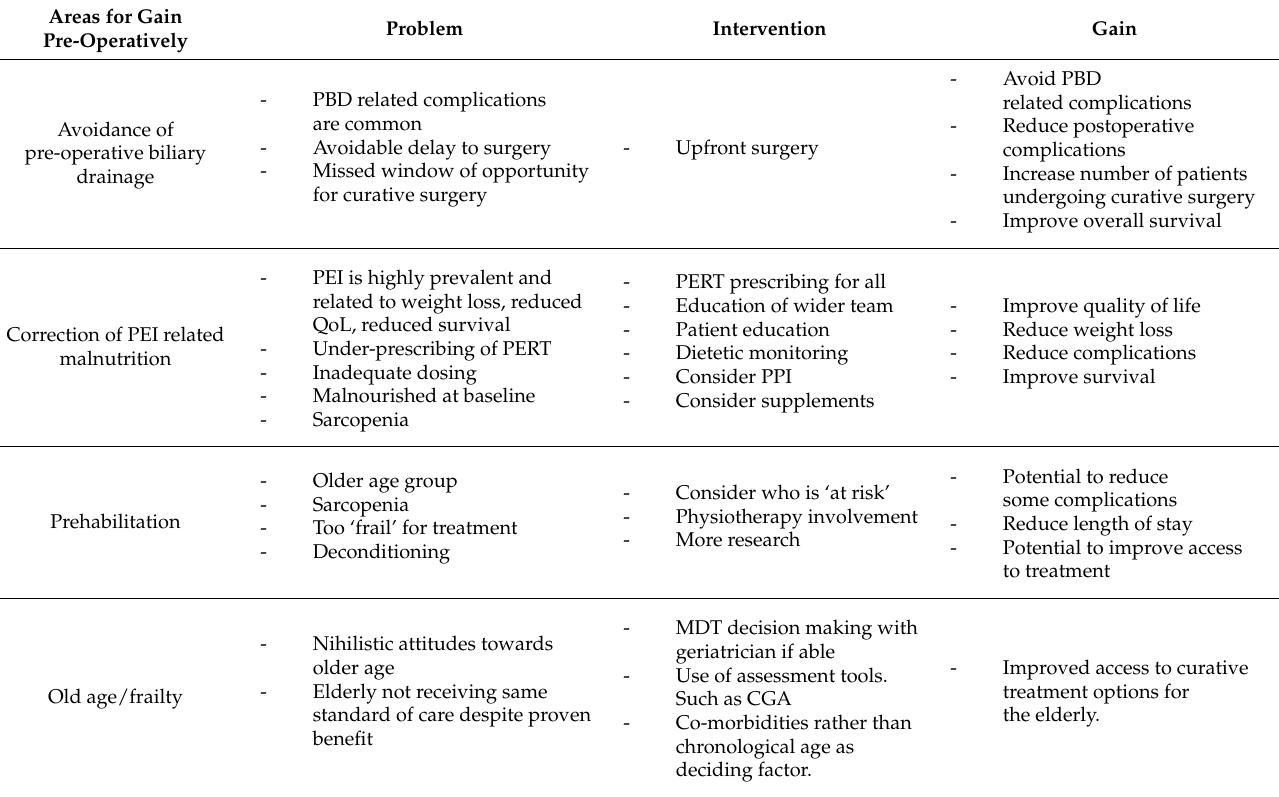
Table 4. Pre-operative areas for potential